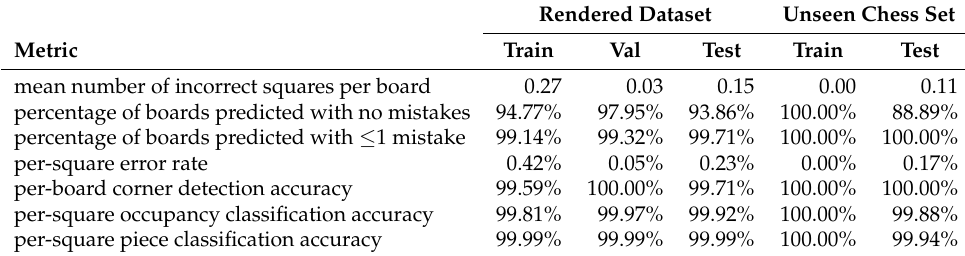
Table 3. Performance of the chess recognition pipeline on the train, validation, and test datasets, as well as the fine-tuned pipeline on the unseen chess